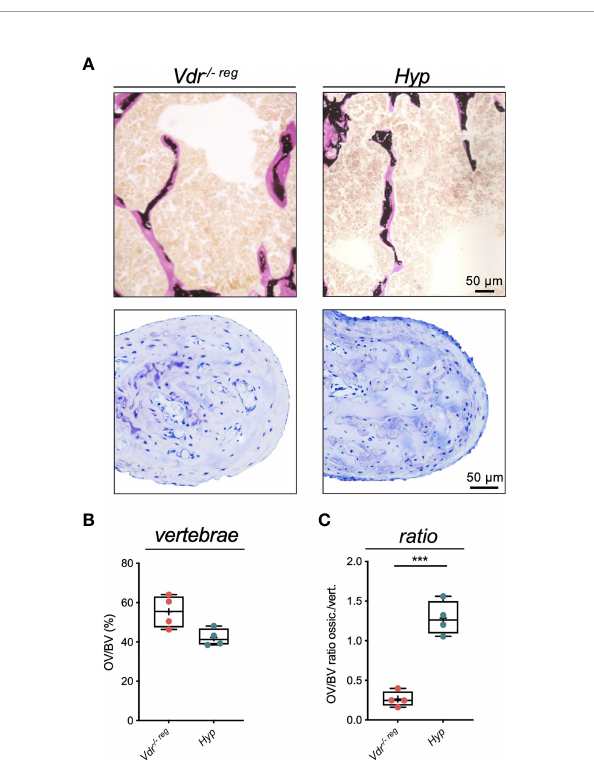
FIGURE 5 | Comparative analysis of osteoid accumulation in the lumbar spine and malleus in Vdr -/- reg and Hyp mice re fl ects peculiarities in ossicular mineralization. (A) Representative images of bone trabeculae in the vertebral bodies (von Kossa-van Gieson staining, upper panel) and of the malleus (toluidine blue staining, lower panel) in Vdr -/- reg mice compared to Hyp mice. Osteoid is stained pink (von Kossa-van Gieson) or light blue (toluidine blue) (B) Quanti fi cation of osteoid volume per bone volume (OV/BV) in the vertebrae. (C) OV/BV ratio between malleus and vertebrae. Student ’ s t-test was used in panels (B) and (C)